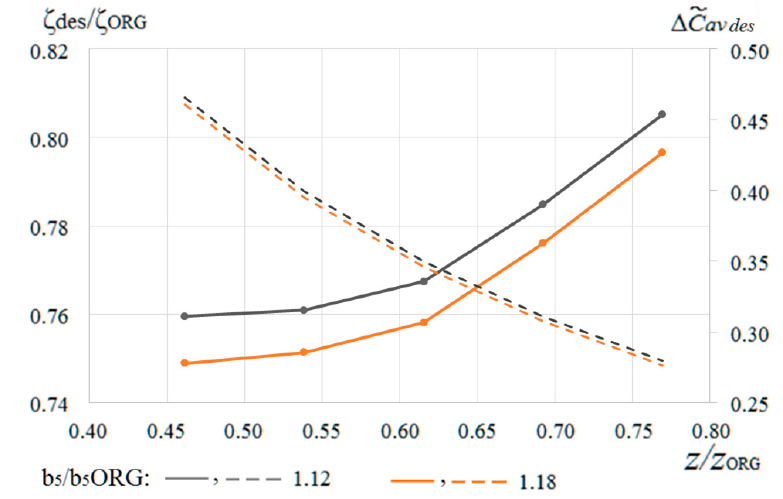
/ , / z z b b and their 5 5 ORG ORG